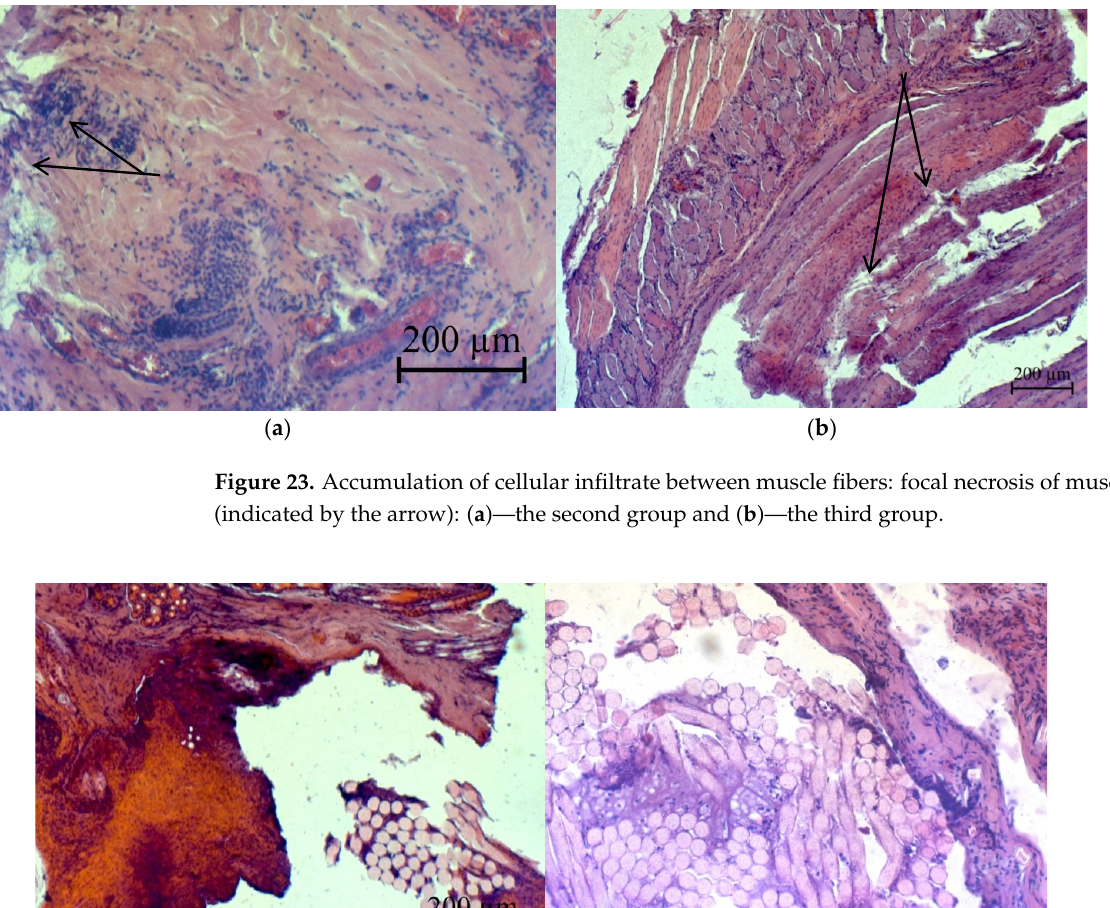
Figure 23. Accumulation of cellular infiltrate between muscle fibers: focal necrosis of muscle fibers (indicated by the arrow): ( a )—the second group and ( b )—the third group. There was no evidence of an allergic reaction of the body at the sites where the suture material was detected. No extensive cellular infiltrates were detected around the suture material, and eosinophils were characteristic of an allergic reaction of the body to foreign bodies (Figure 24).